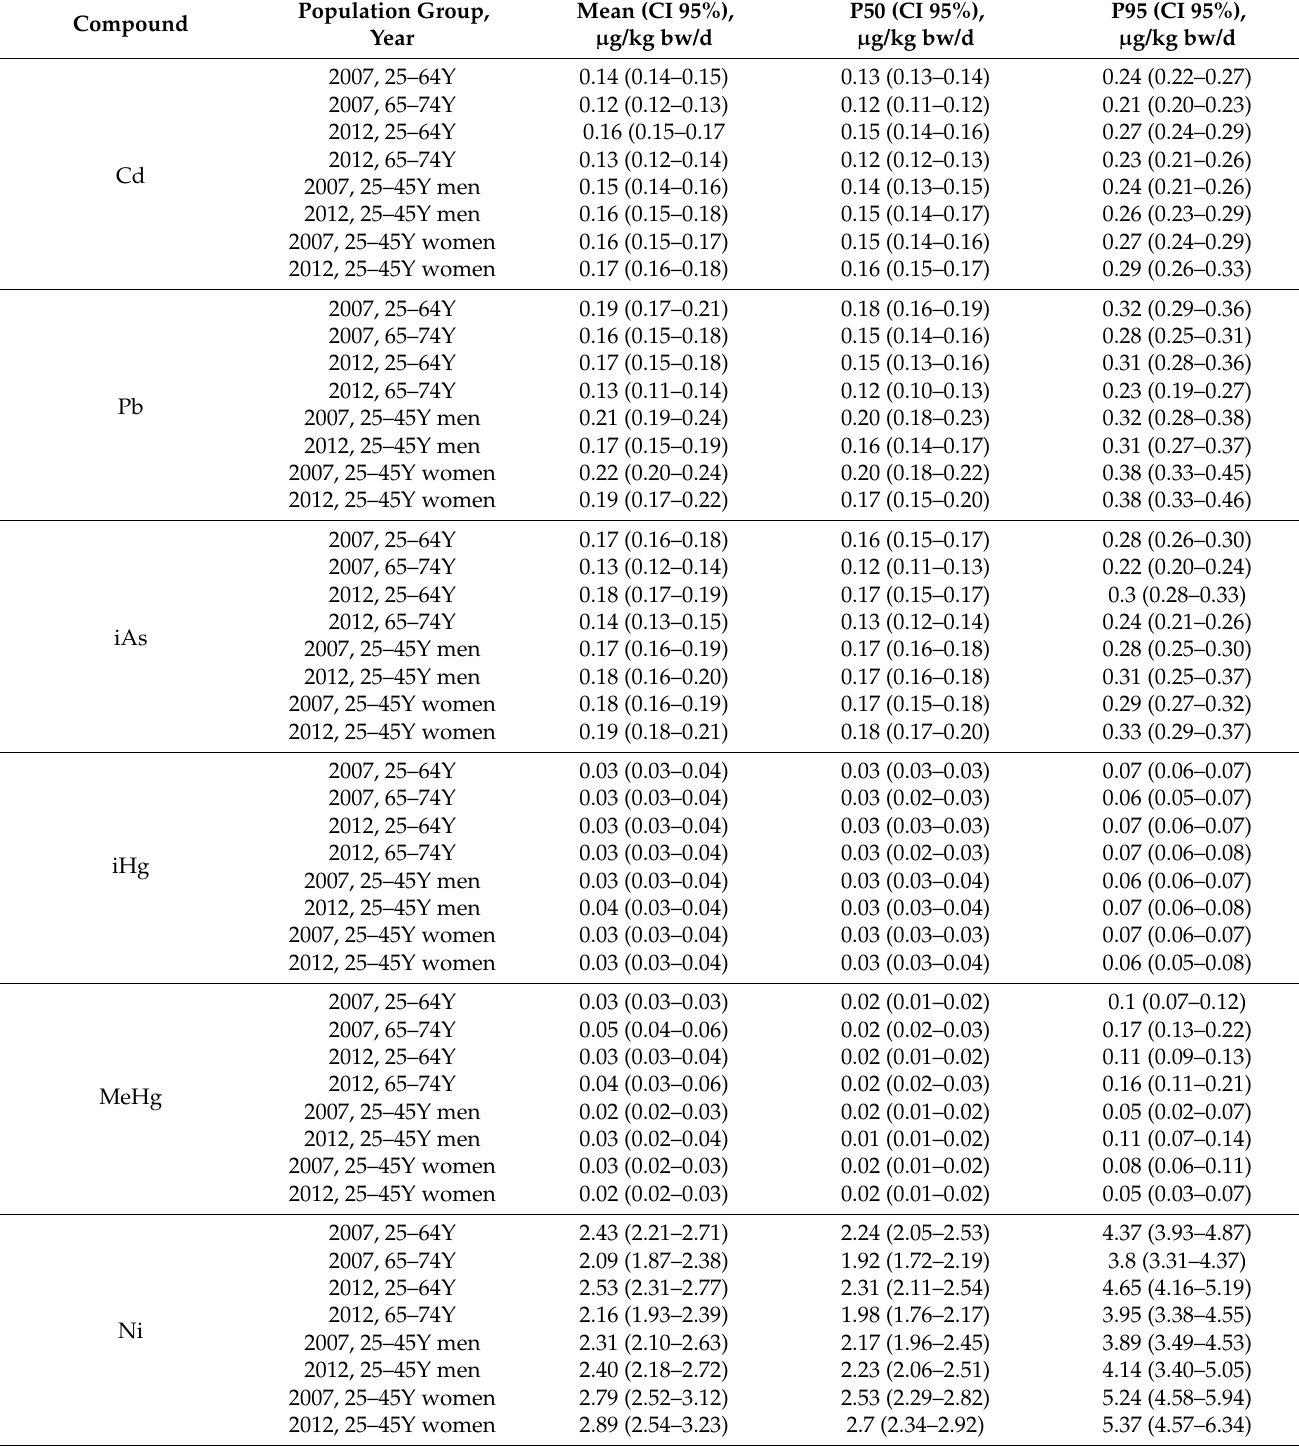
Table 3. Mean, median (P50) and 95th-percentile (P95) exposures in the different groups, shown as µ g/kg bw/d. Results for Cd and Hg should thus be compared with 1/7 of the TWI values shown in Table 2. The 2012 exposure assessment on lead used a dataset where the milk results were limited to the years 2010–2016, all below the limit of reporting, while the 2007 assessment also included older milk data with numerical results. Therefore, the lead results are not directly comparable between the